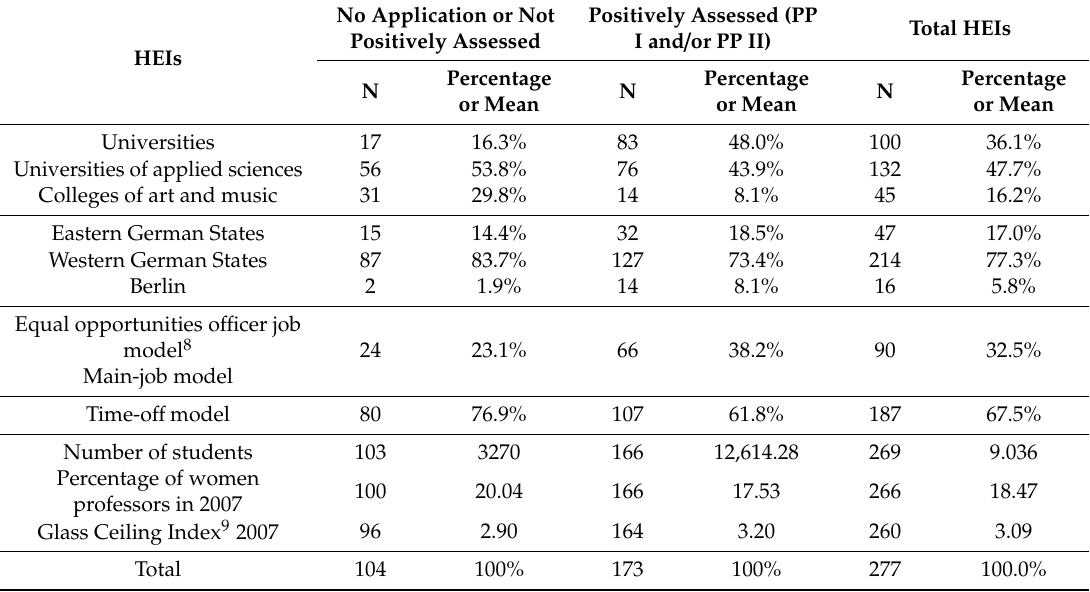
Table 3. Characteristics of Participating and Non-Participating HEIs (HEI Type, Regional Distribution, HEI Size, and Proportion of Women